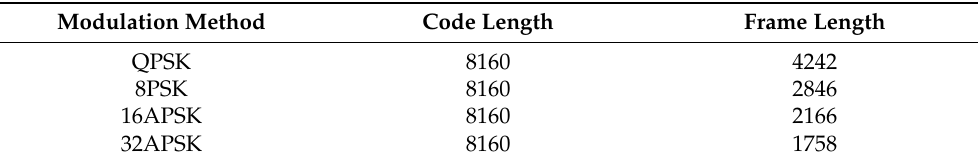
Table 1. VM system simulation